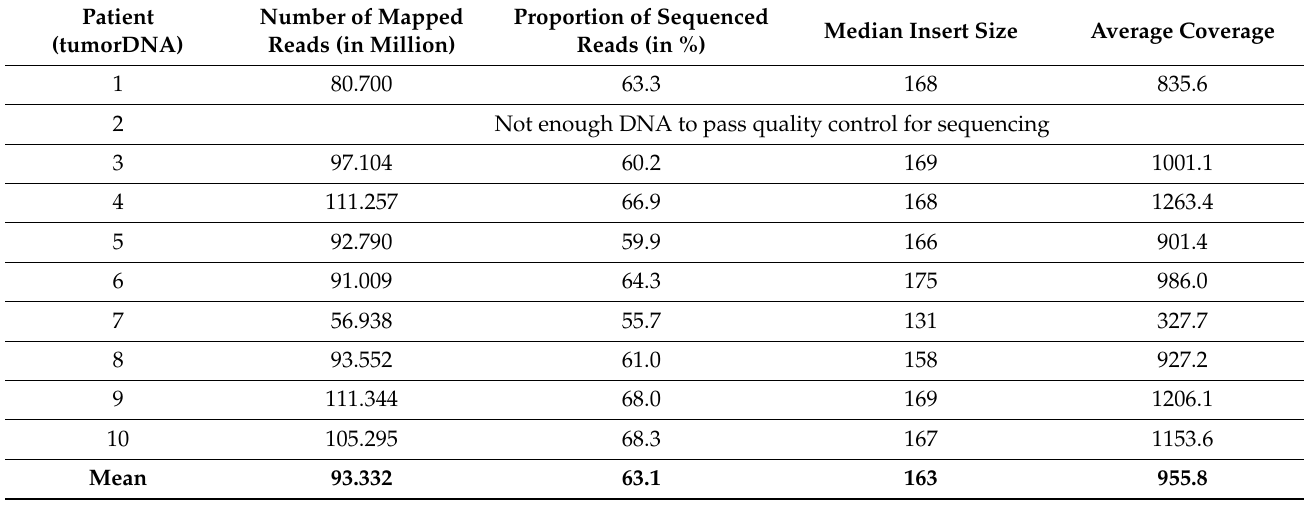
Table 2. Quality parameters of sequencing data for tumorDNA.